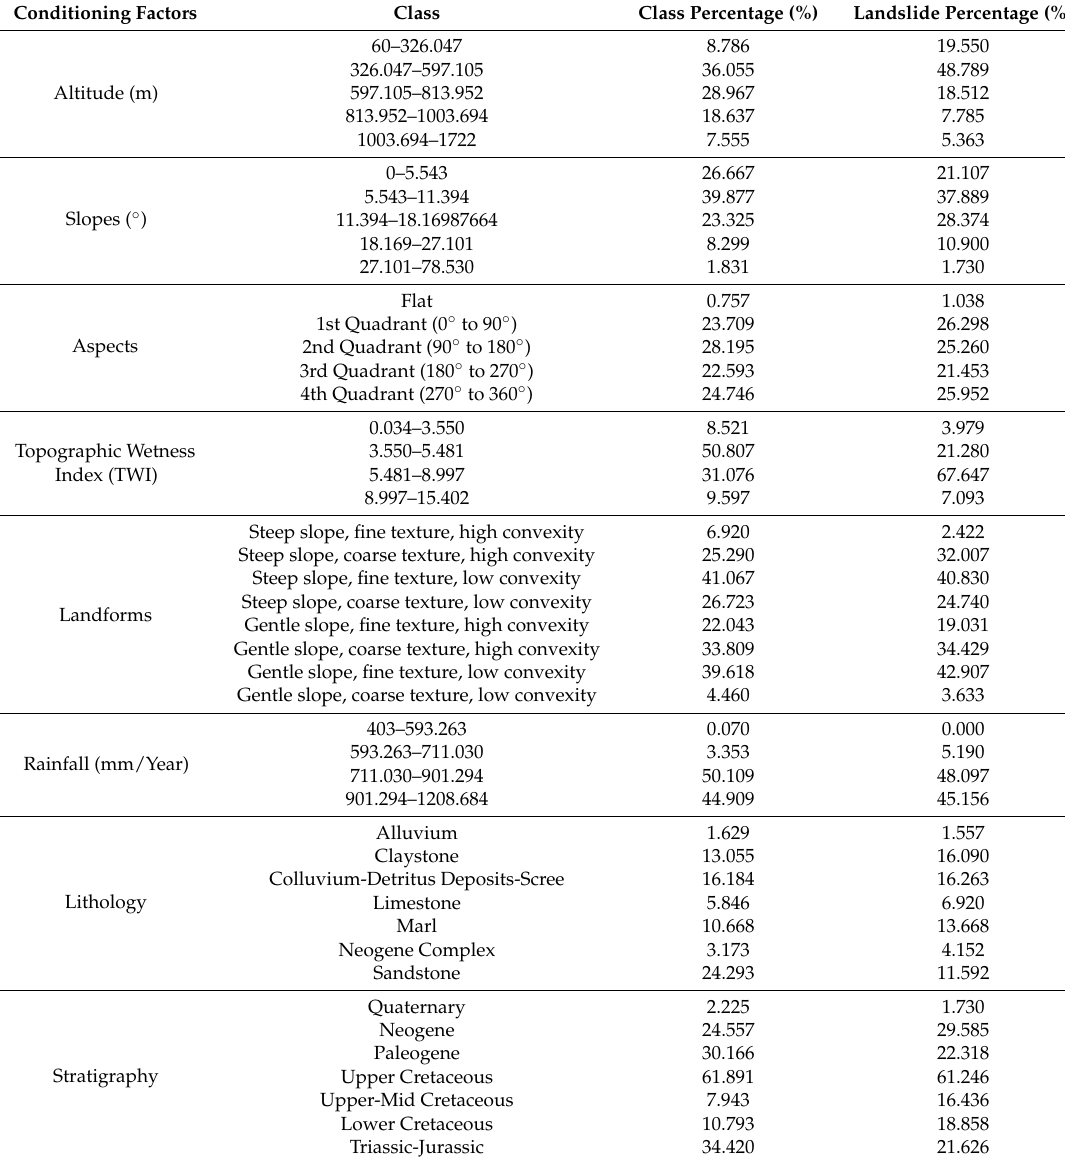
Table 2. The spatial relationship between the landslide conditioning factors and landslides by frequency